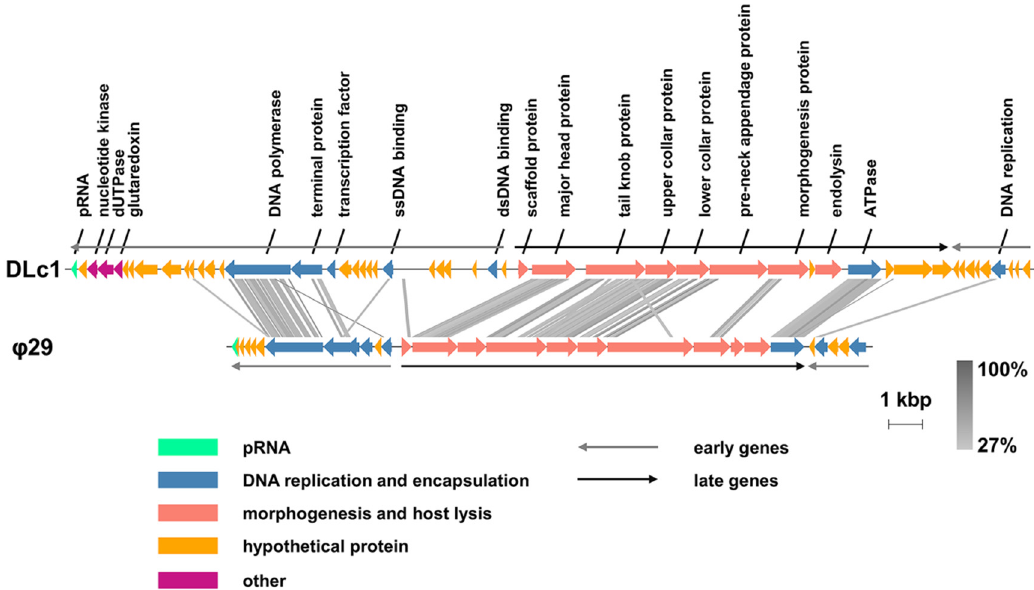
Figure 2. Overview of the DLc1 genome compared to the type strain ϕ 29. Predicted functions of the open reading frames (ORFs) are indicated and the tblastx similarities between two genomes are displayed as vertical grey lines, with grey levels representing the degree of similarity.